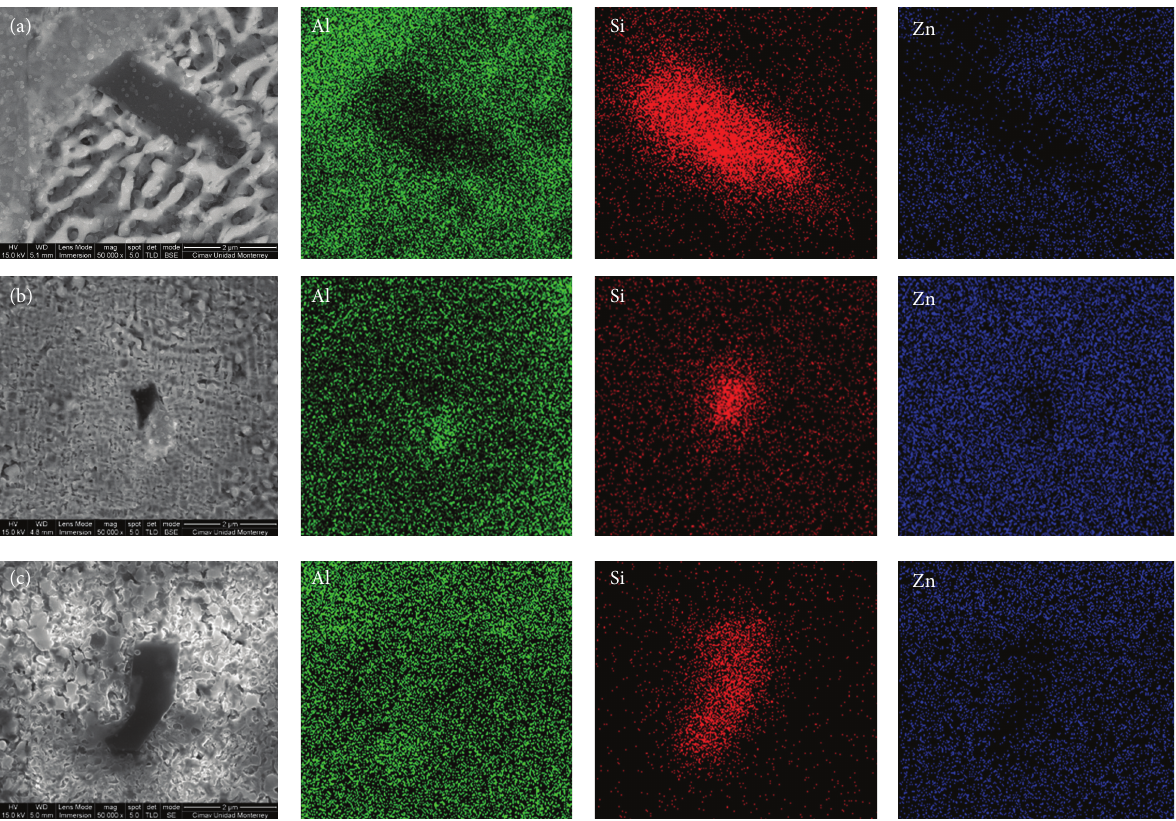
Figure 9: Maps of Al, Si, and Zn element distribution observed in the microstructures of Al-Zn-1.0Si alloy (wt%) at cooling rates of (a) 11.7 ∘ Cs −1 , (b) 29.6 ∘ Cs −1 , and (c) 47.0 ∘ Cs −1 .